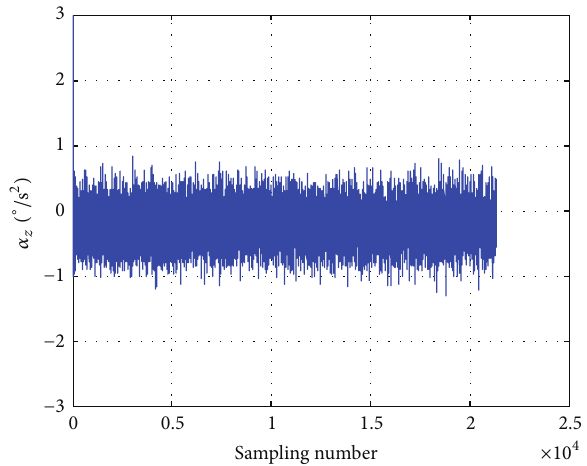
Figure 18: 𝛼 𝑧 for uncontrolled system.